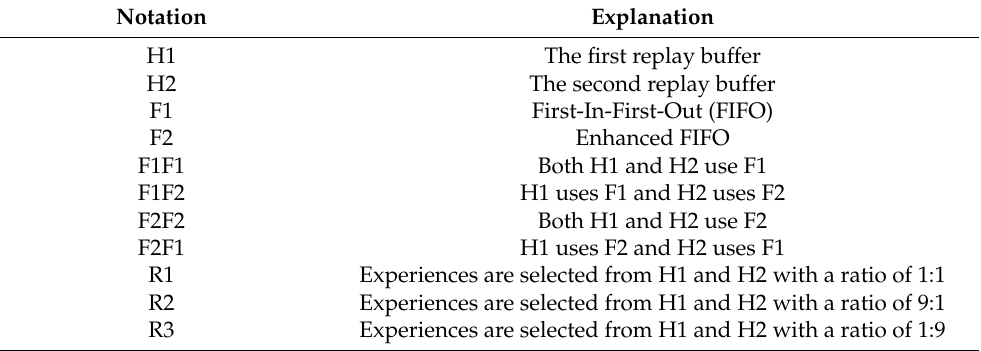
Table 4. List of major